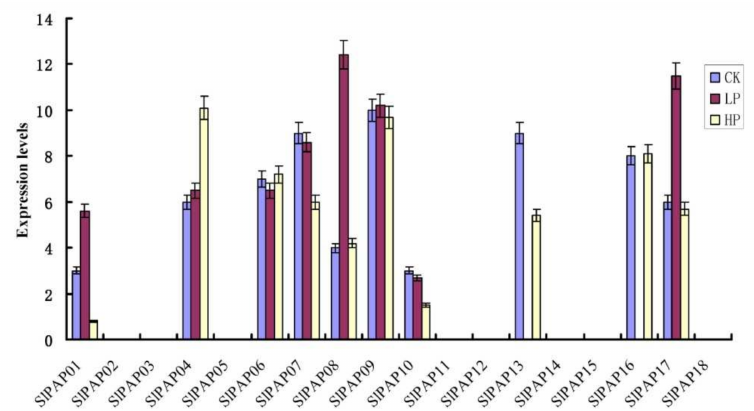
Figure 6. Expression profiles of PAP genes in tomato in response to low- and high-phosphate stress. Heat maps are presented in green/black/red/colors that represent low/medium/high expressions, respectively.